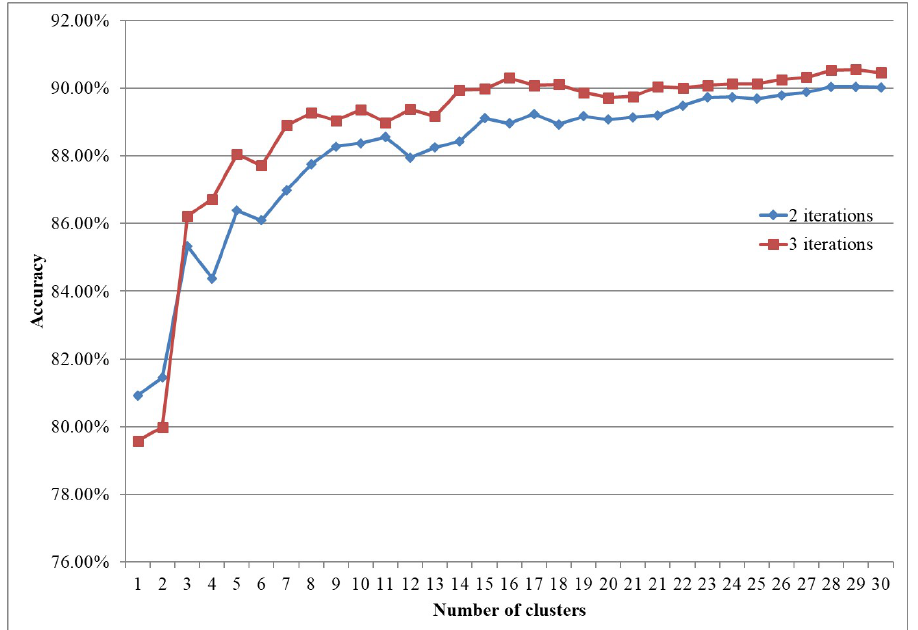
Figure 11. Influence of number of